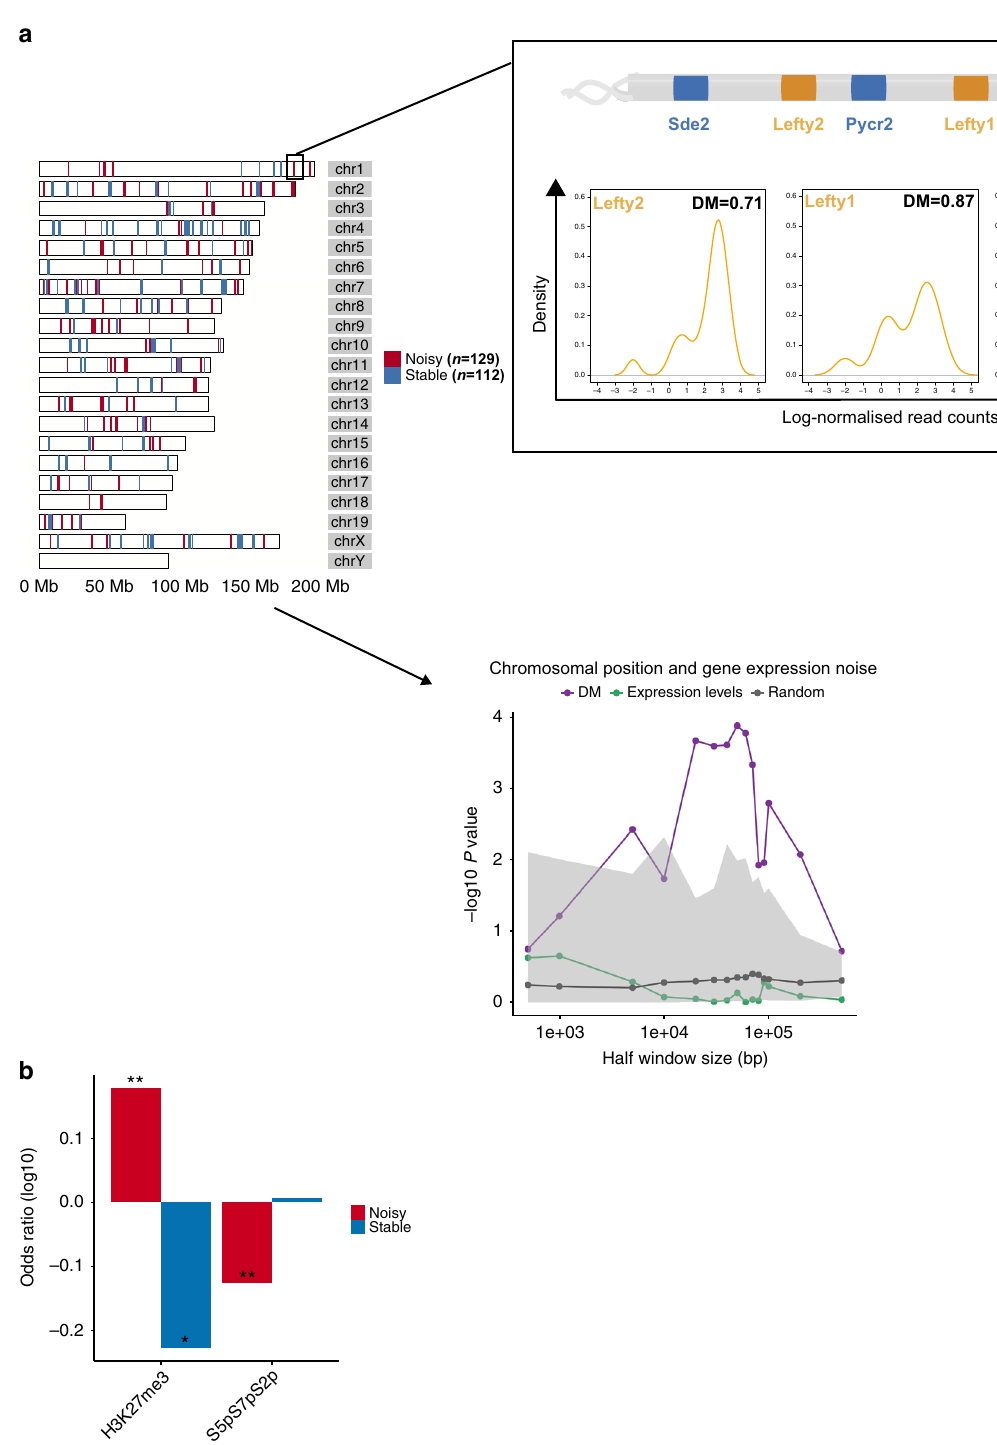
Fig. 4 Chromosomal position effects and stochastic gene expression. a Maps of genes belonging to noisy and stable clusters. Chromosomal positions of genes marked by PRCs and RNAPII in the noisiest clusters. One of the noisy clusters is visualized, DM levels correlate with bimodal expression patterns. In lower panel , association between chromosomal position and gene expression noise is shown; the noise levels of genes in the neighborhood of noisy genes are signi fi cantly higher than those of fl anking genes of stable genes. As a control, we constructed 100 randomized genomes in which the positions of genes were fi xed but the DM value of each gene was assigned randomly without replacement, and the same analysis was performed on each randomized genome to obtain random P values. In all, 2.5% quantile of random P value, and 97.5% quantile of random P values are shaded in gray . All data are shown on a − log(p) scale. b Enrichments of PRC marks and RNAPII states in noisy and stable clusters; two-tailed Fisher ’ s exact test; * P < 0.1, ** P <